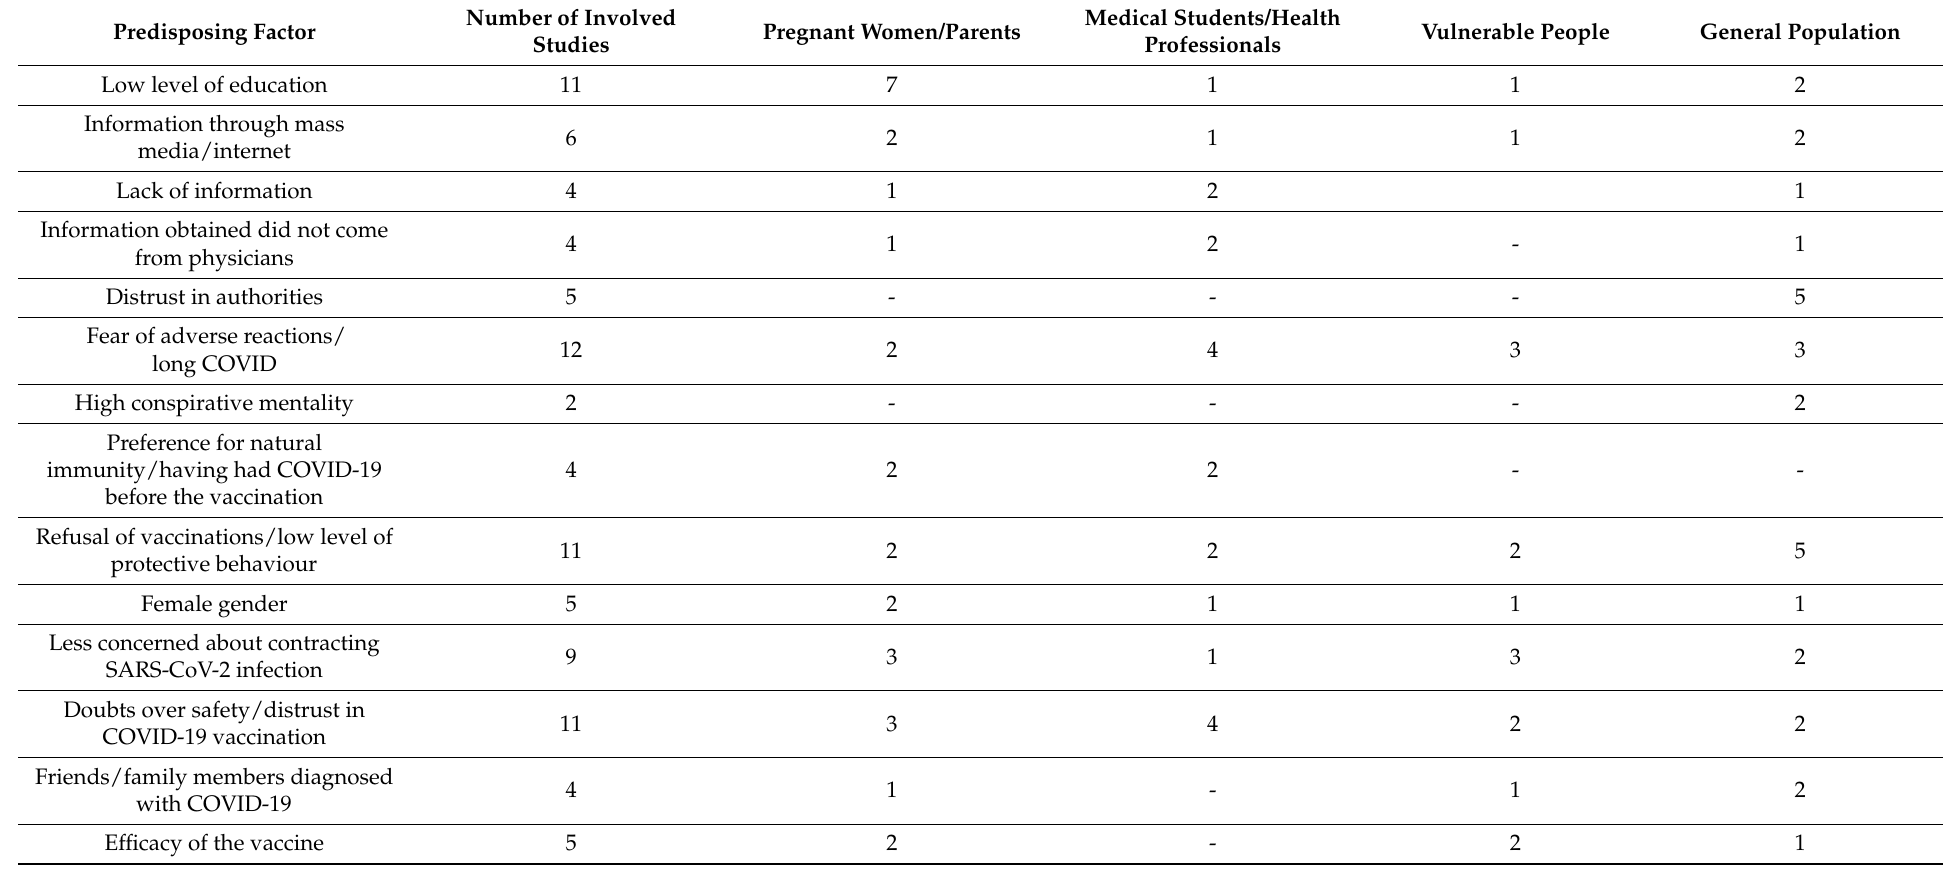
Table 2. Most frequently encountered factors predisposing vaccine hesitancy in the Italian